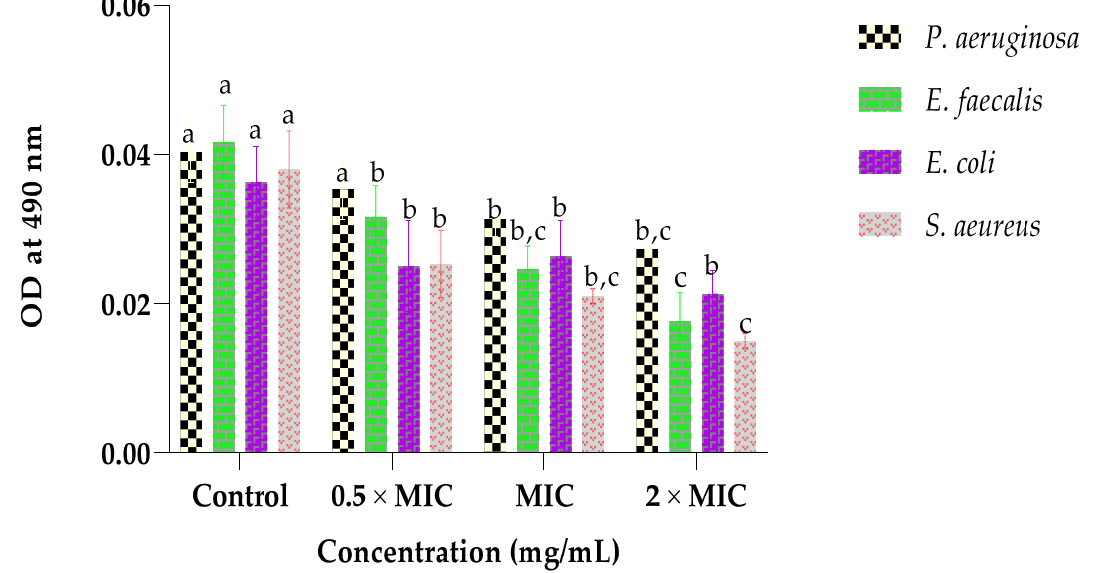
Figure 1. Effect of the whole leaf extract on the respiratory chain dehydrogenase activity of P. aeruginosa , E. faecalis , E. coli and S. aureus . The different superscripts (a, b and c) illustrate the statistically significant ( p < 0.05) per bacterium; similar letters indicate no statistical difference ( p > 0.05).